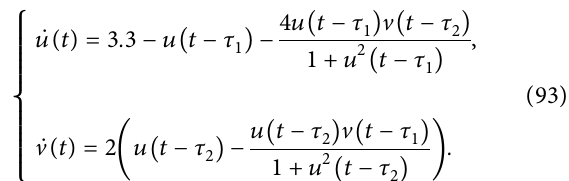
� 0 , τ � 0 . 23 > τ � 0 . 2061 at the initial value ( 1 , 1 ) 1 2 20